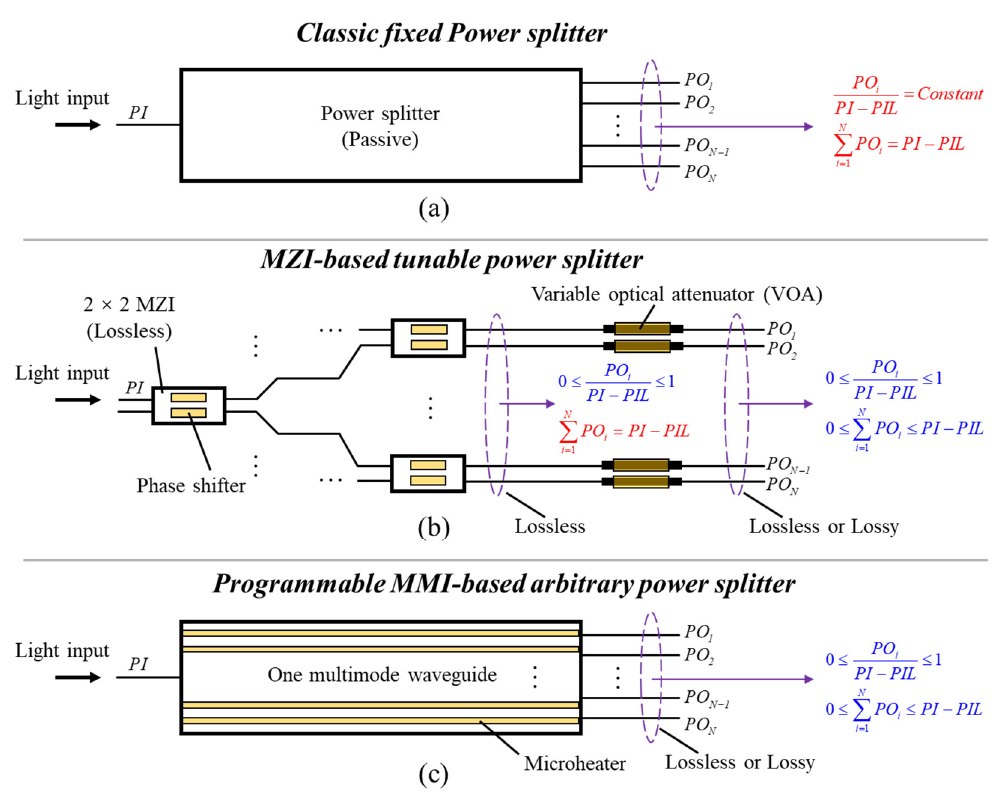
Figure 1. Schematic of the ( a ) classic fixed power splitter, ( b ) MZI-based tunable power splitter in- tegrated with variable optical attenuators (VOAs), and ( c ) programmable MMI-based arbitrary power splitter. PO i , power of the output Port i ; PI , power of the input light; PIL , lost power due to device insertion loss in practice.